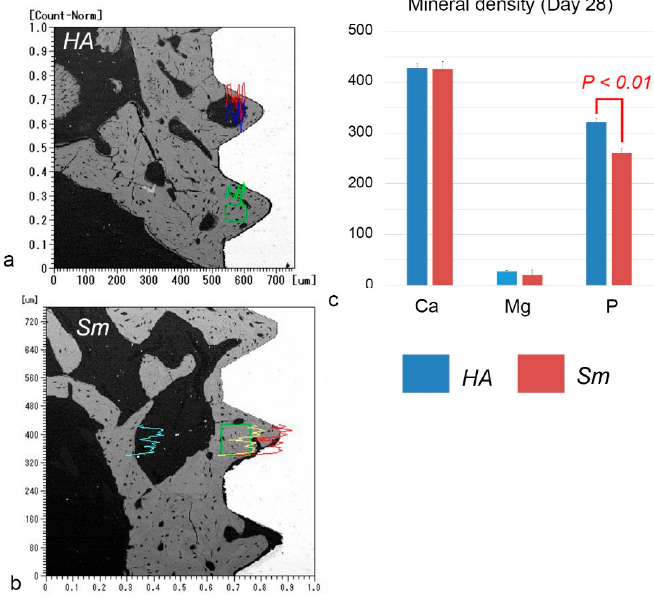
Figure 6. Quantitative analyses of the element densities of calcium, magnesium, and phosphorus in the surrounding bone demonstrate a significant difference in the phosphorous levels between the HA and Sm groups. The boxes in ( a , b ) indicate the areas analyzed for the element density. ( a , b ) Back scattered electron images. The line graphs colored with red, green, and blue or yellow indicate the mineral density of calcium, magnesium, and phosphorus, respectively. ( c ) The phosphorus level is significantly higher in the HA group for mineral density at postoperative week